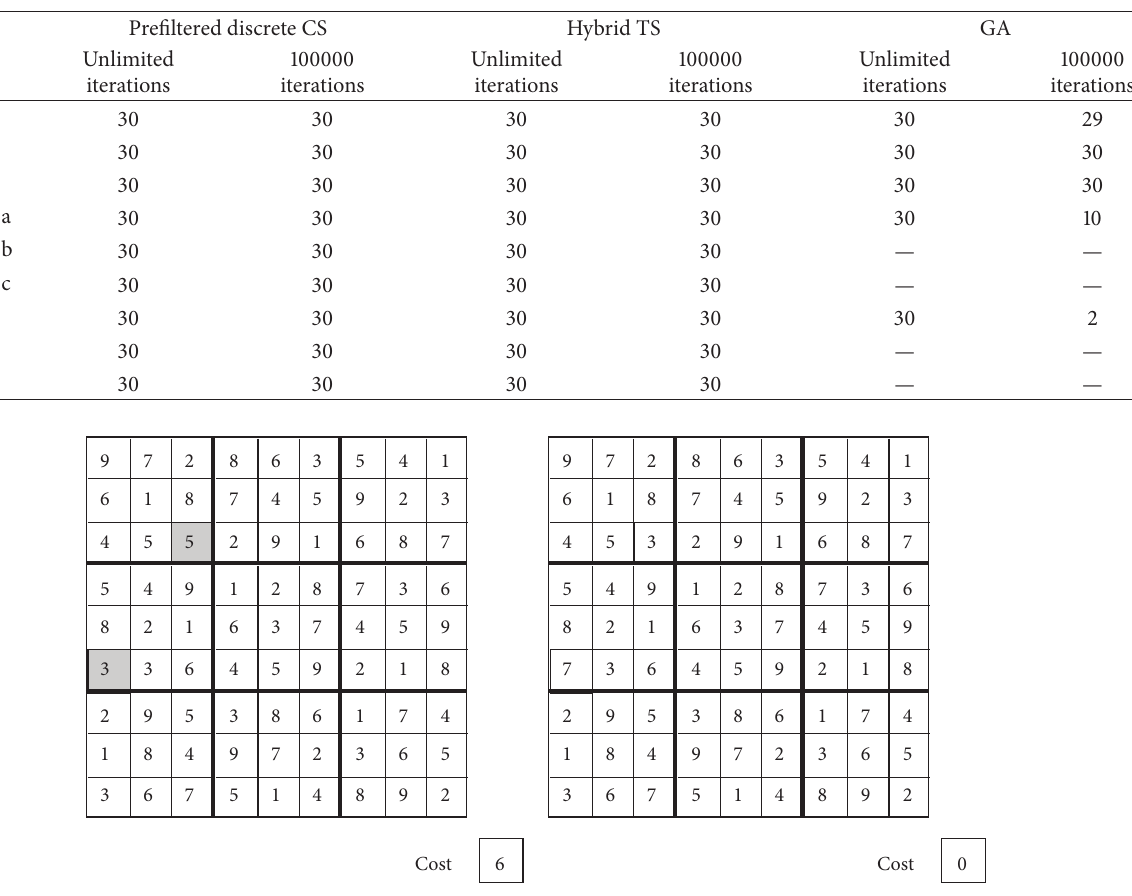
Table 2: Comparing the prefiltered discrete cuckoo search with the best-performing incomplete methods for Sudokus considering 100000 and unlimited iterations.